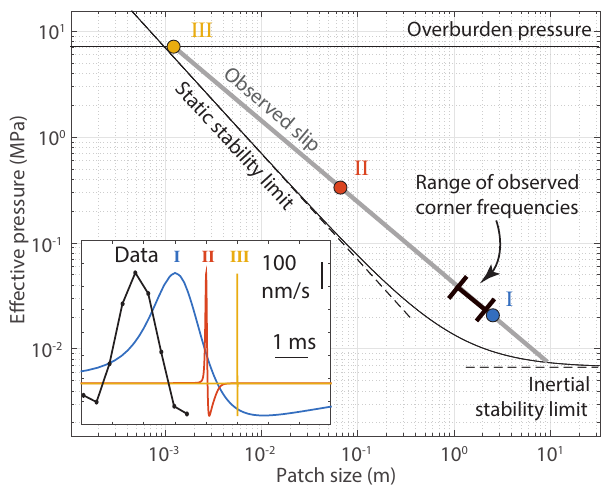
Figure 6. A diagram showing the range of patch size-effective pres- sure R − ¯ σ conditions that give rise to fault slip D obs = 40µms − 1 (thick grey line). This figure shows a snapshot of parameter space at one instance during a tremor episode; the full evolution of parame- ters is shown in Fig. 5. The heavy grey line shows the subset of pa- rameter space that is also consistent with observed corner frequen- cies. The fault is loaded with velocity V s = 0 . 4mms − 1 . The lower thin curve shows the boundary of the stability region Eq. (17). The horizontal line shows the overburden stress ρ i gH . The inset shows a representative wave pulse recorded at high rate at station GS07 on 14 December 2010 as compared to three simulated wave forms. The bed shear modulus G b for the simulations is chosen from Fig. 5 to be 15MPa. Each simulation has the same seismic amplitude and slip; they differ only corner frequency ( f c ≈ 30, 750, and